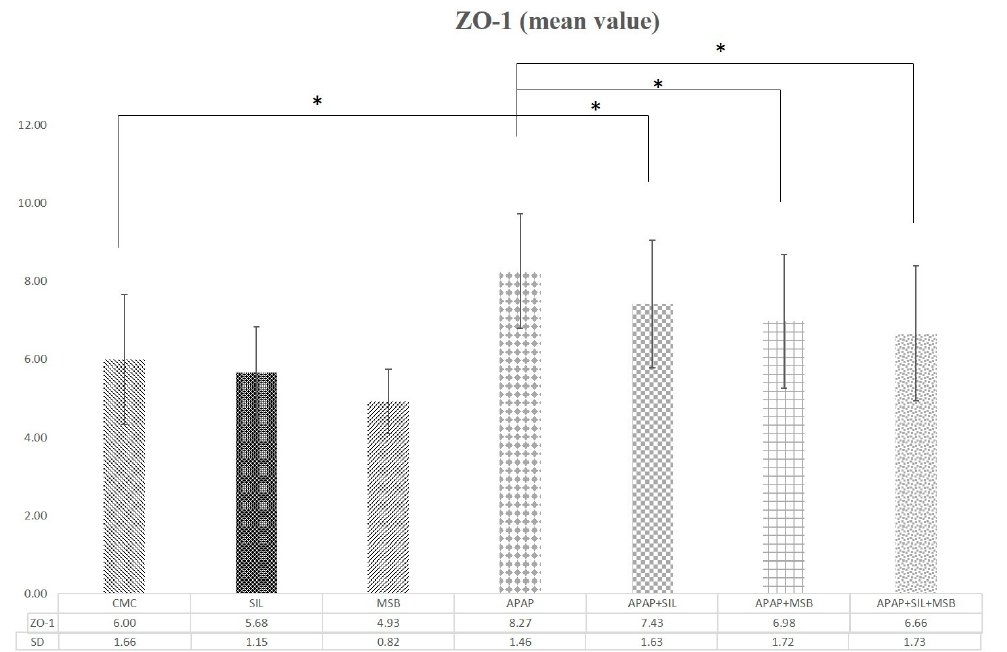
Figure 5. Changes in tight junction protein (ZO-1) levels. Rats were treated with 1% CMC, SIL, MSB, APAP, APAP + SIL, APAP + MSB or APAP + SIL + MSB. Periorbital blood was collected on Day 13 and the serum was tested for ZO-1 levels. * Significant difference ( p < 0.05) between groups; data were analyzed using one-way ANOVA. Abbreviations: APAP, N-acetyl-p-aminophenol or paracetamol (acetaminophen); CMC, carboxymethylcellulose; MSB, MegaSporeBiotic™; SIL, silymarin; ZO-1, zonula occludens.